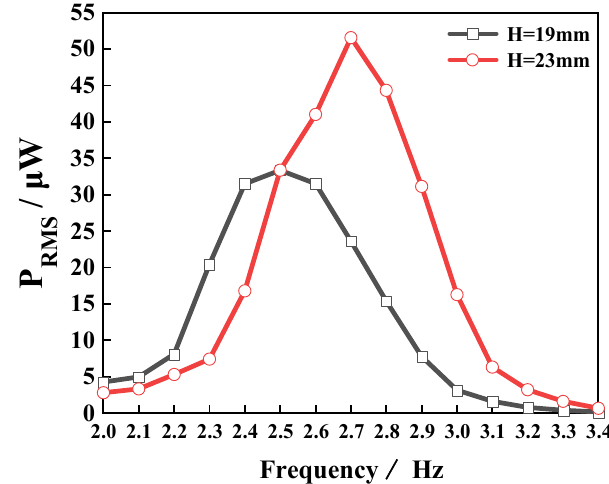
Figure 14. The effect of the liquid height on the PVEH output characteristics.